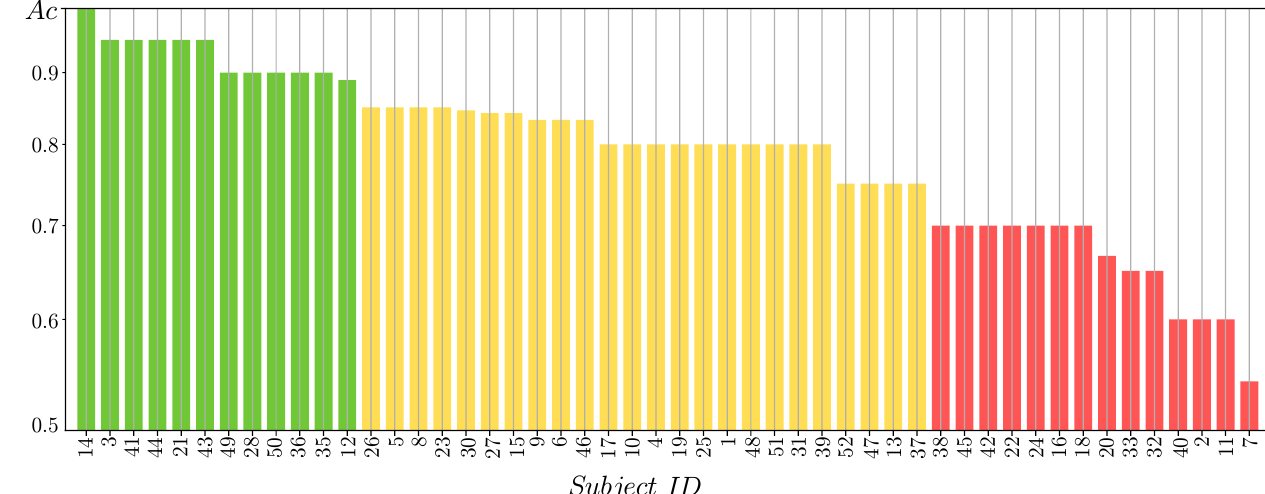
Figure 3. Partitions of individuals clustered by the MLP-based accuracy. Each subject performance is painted by this estimated BCI inefficiency partition: Group I (green), Group II (yellow), and Group III